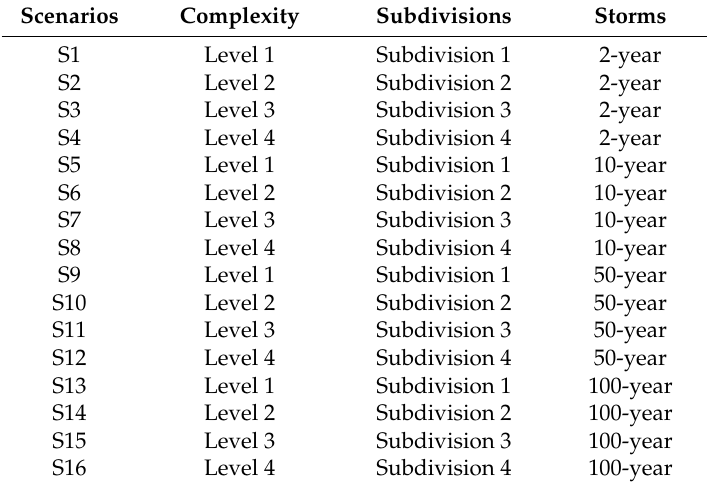
Table 2. Scenario design in this study.